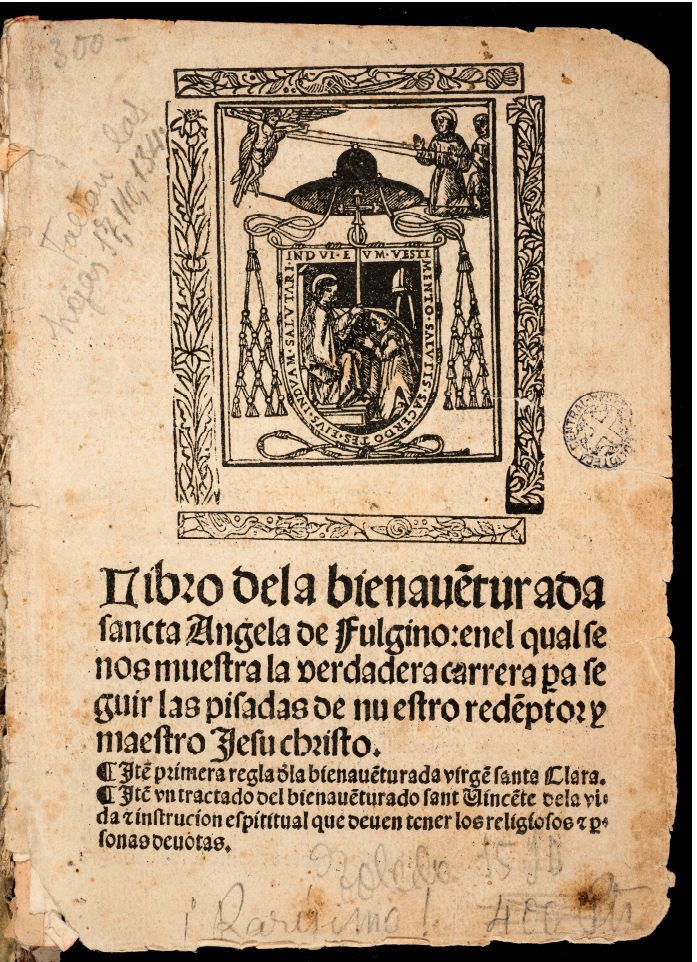
Figure 1. Francesco receiving the stigmata and the Virgin presenting the chausuble to Ildefonso de Table 1510. (= Angela da Foligno 1510); Barcelona, Biblioteca de Catalunya, Res 751-12°, cover.